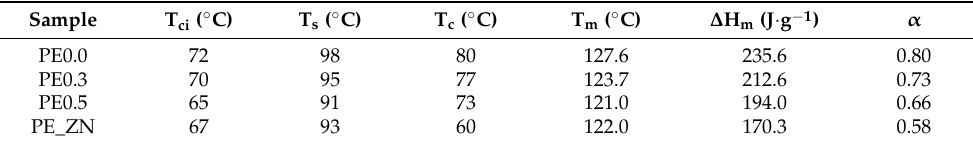
Table 3. Self-seeding crystallization conditions for the preparation of single crystals (initial temper- ature of crystallization, T ci ; seeding temperature, T s ; crystallization temperature, T c ) and thermal properties (melting temperature, T m ; melting enthalpy, ∆ H m ; and crystallinity, α ) measured by DSC.